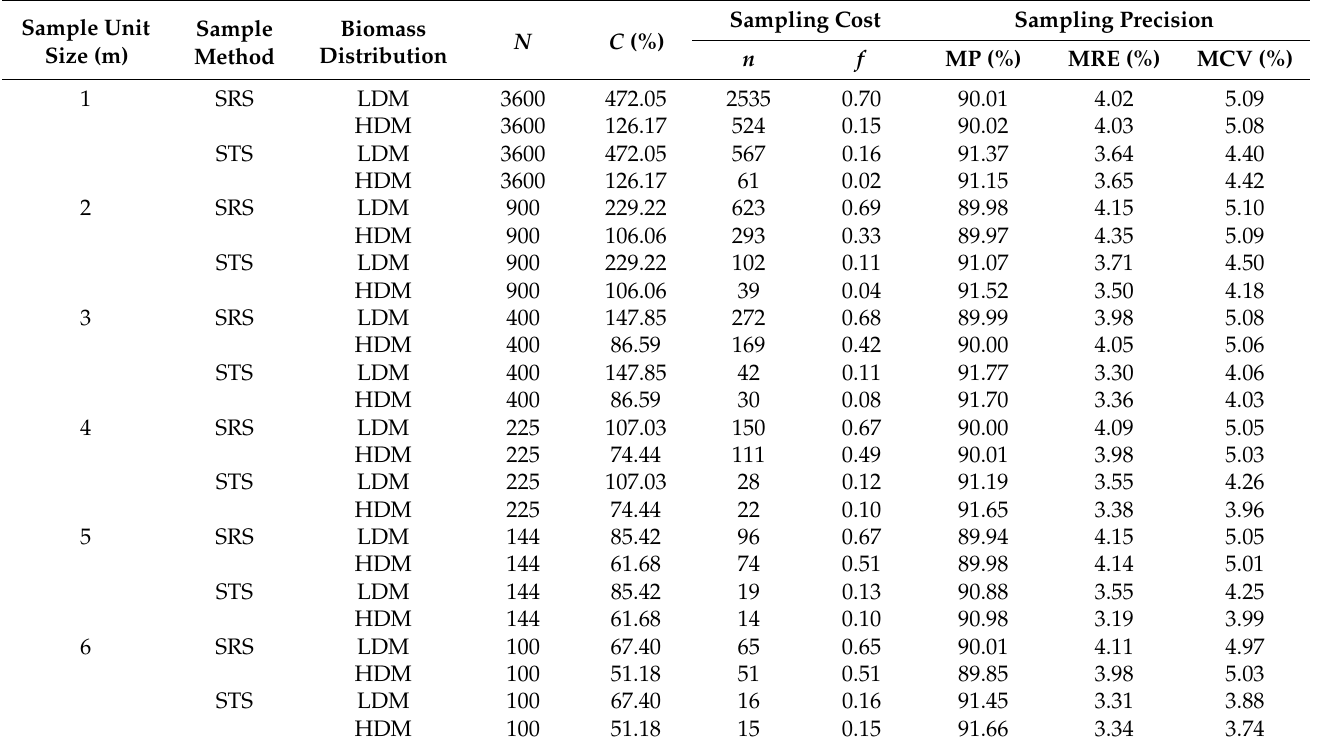
Figure 8. Effect of different biomass sampling estimation schemes on sampling ratios. ( a ) Variation of sampling ratio; and ( b ) the savings in sampling ratio of the HDM method schemes compared to the LDM method schemes. Table 4. Evaluation of sampling efficiency of different biomass sampling estimation